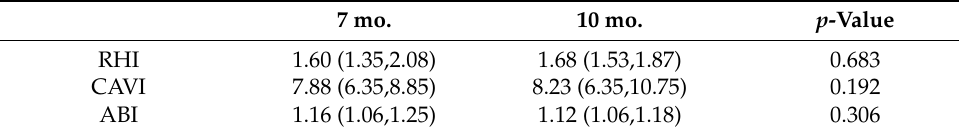
Table 8. Changes in arteriosclerosis index at seven and ten months ( n =